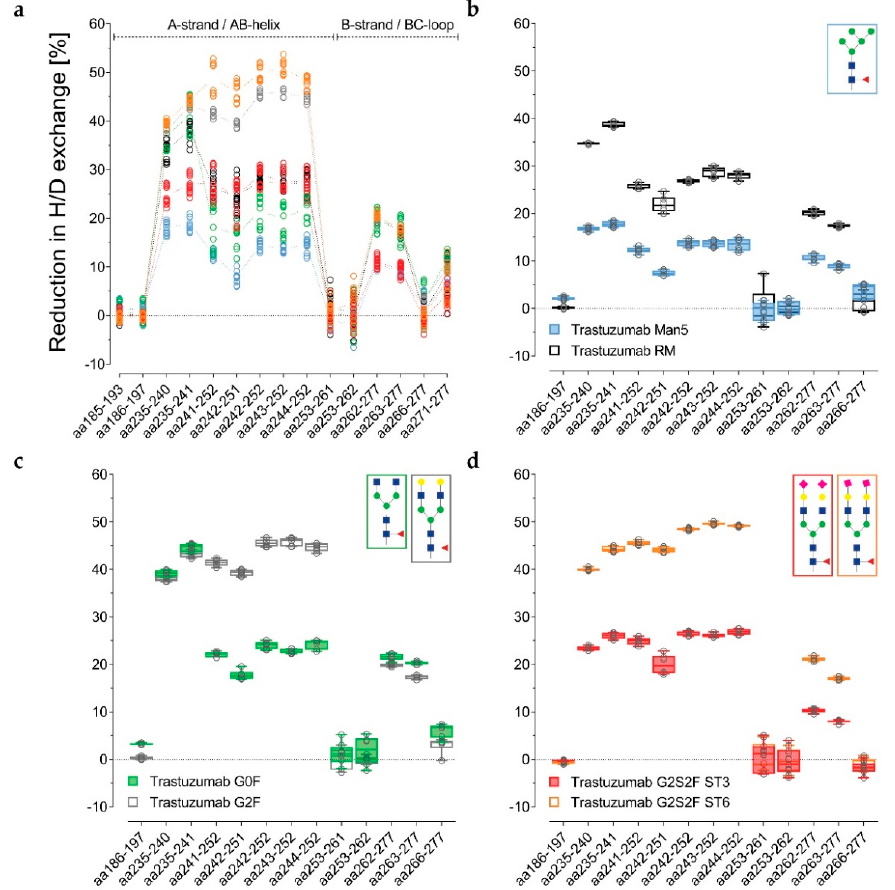
Figure 3. Reduction in H / DX (%) of trastuzumab glycan variant C γ 2 domain peptides, resulting from pepsin or pepsin / type XIII digestion (sequence coverage 87–94%), normalized with the de-glycosylated trastuzumab sample. ( a ) Single peptide values of three targeted (10 min H / DX) experiments with trastuzumab Man5 (light blue), G0F (green), RM (black), ST3 (red), G2F (gray), and ST6 (orange). ( b – d ) Box plots with single peptide values of single experiments ( n = 6) and representing boxes showing minimum, 25th percentile, median, 75th percentile, and maximum values. Additional statistical significance testing was as recently described by Hagemann et al.; see Figure S3 [60].